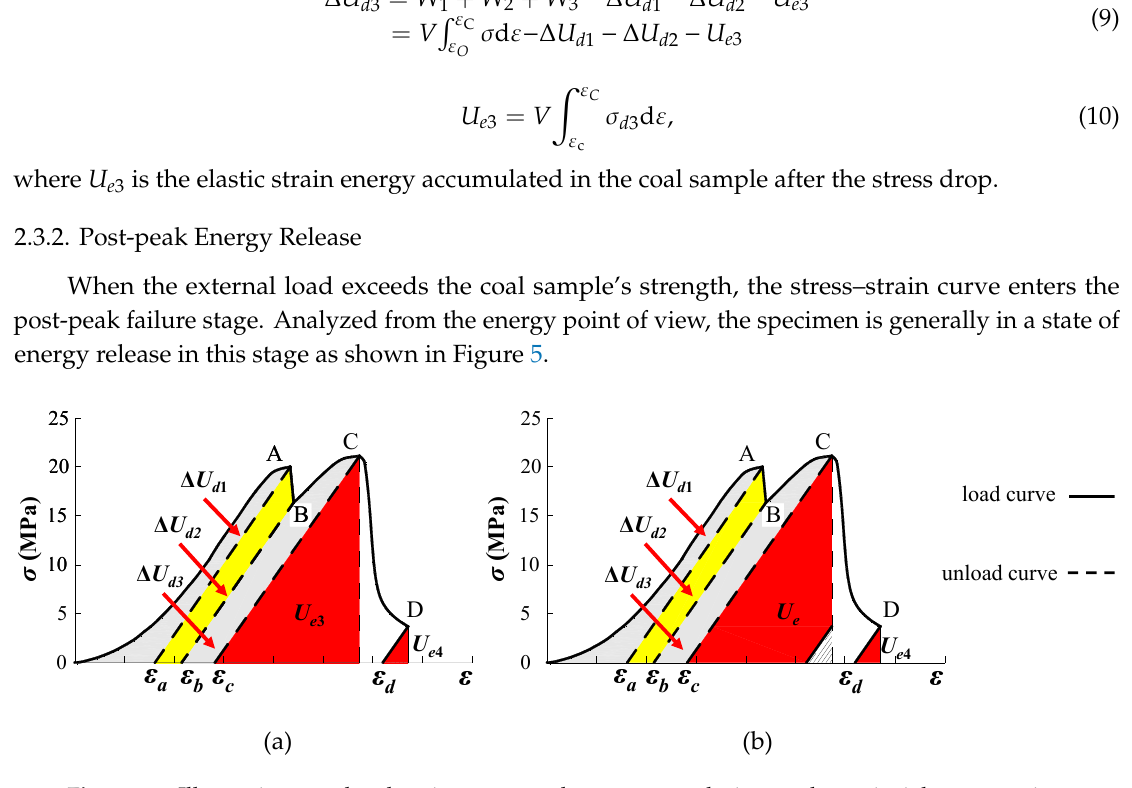
Figure 5. Illustrative graphs showing post-peak energy revolution under uniaxial compression. ( a ) residual elastic strain energy in the specimen when the stress drops to the residual strength, namely and ( b ) the releasable elastic strain energy in the post-peak stage.